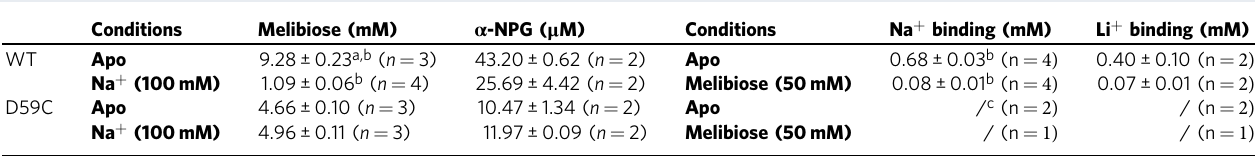
n , the number of tests. The protein conditions for each individual test were in bold. a SE, Standard error. b Data from the publication in ref. 22 or averaged with more tests. c No curve fi tting was carried